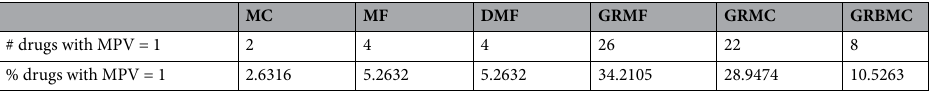
Table 2. Number and percentage of drugs predicted with MPV = 1 by the matrix completion